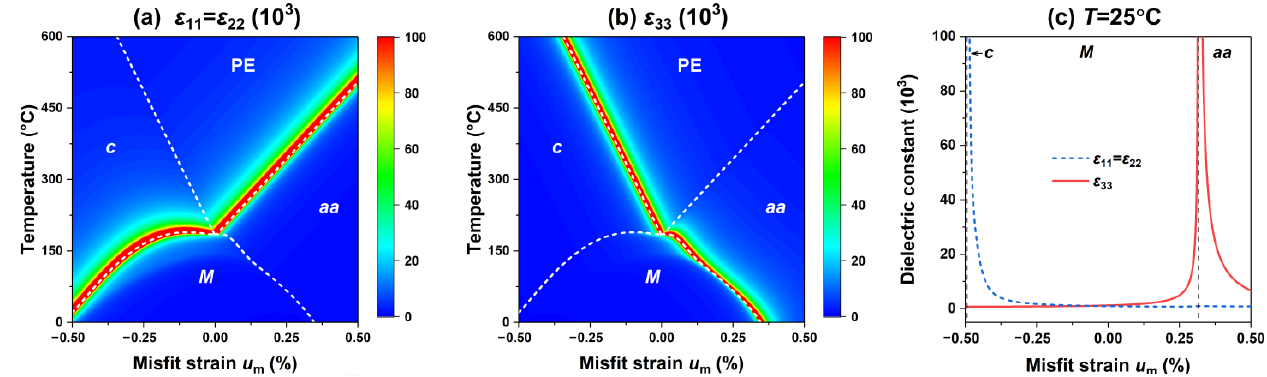
Figure 1. ( a , b ) The misfit strain-temperature phase diagrams in the absence of external electric field, and the corresponding ( a ) in-plane polarization components P 1 , P 2 , and ( b ) the out-of-plane polari- zation components P 3 . ( c ) The corresponding polarization components as functions of misfit strain u m at room temperature. The color bar illustrates the value of polarization.